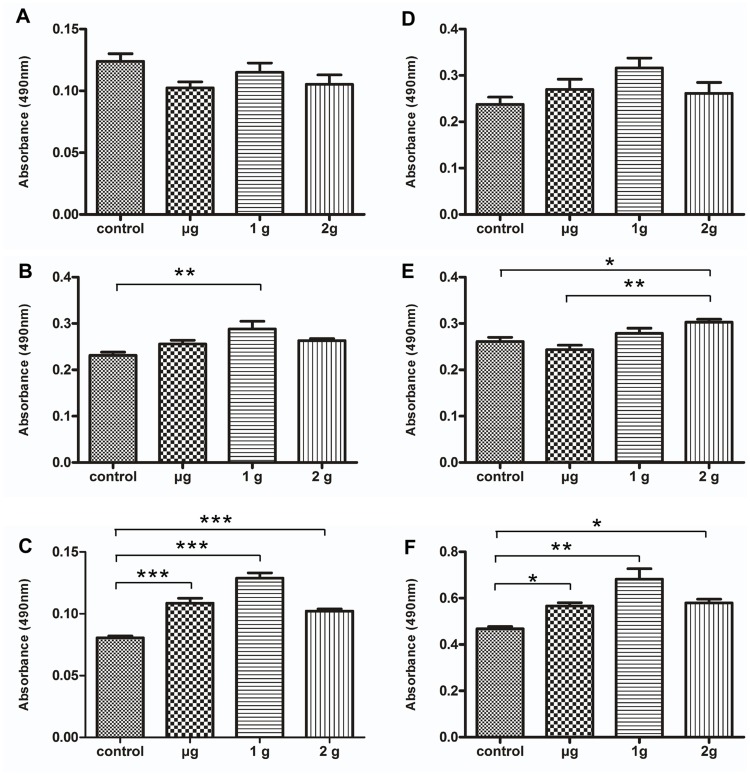
MTT analysis of the effects of LG-HMF on the viability of MC3T3-E1 (A–C) and MG-63 (D–F) cells.After MG-63 and MC3T3-E1 cells were cultured at 37°C for 12 h, 24 h, and 48 h in the bore of the superconducting magnet, the cells were removed from LG-HMF. The MTT assay was used to detect the effects of LG-HMF (μ-g, 1-g, and 2-g) on cell viability. Cell viabilities increased slightly in both cell lines compared to control conditions after 24 h or 48 h of exposure to LG-HMF (P<0.05). A–C: MG-63 cells; D–F: MC3T3-E1cells. A, D: exposure to LG-HMF for 12 h; B, E: exposure to LG-HMF for 24 h; C, F: exposure to LG-HMF for 48 h. *: P<0.05, **: P<0.01, ***: P<0.001.